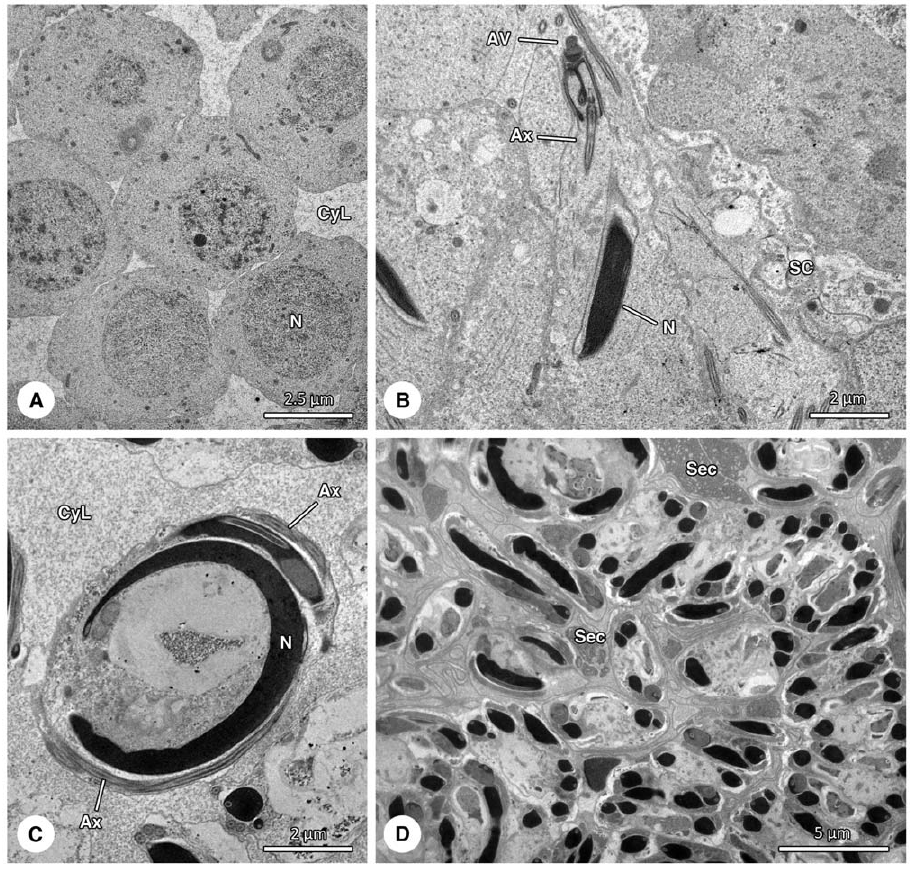
Figure 4. Ultrastructural aspects of spermatogenesis in Nephila clavipes . (A) Early spermatids. (B) Longitudinal section of mid-stage spermatids with condensed and elongated nuclei. (C) Coiled spermatid in a spermatogenic cyst. (D) Coiled sperm cells and secretion in the lumen of the testis. Abbreviations: AV, acrosomal vacuole; AX, axoneme; CyL, lumen of spermatic cyst; N, nucleus; SC, somatic cell; Sec, secretion.